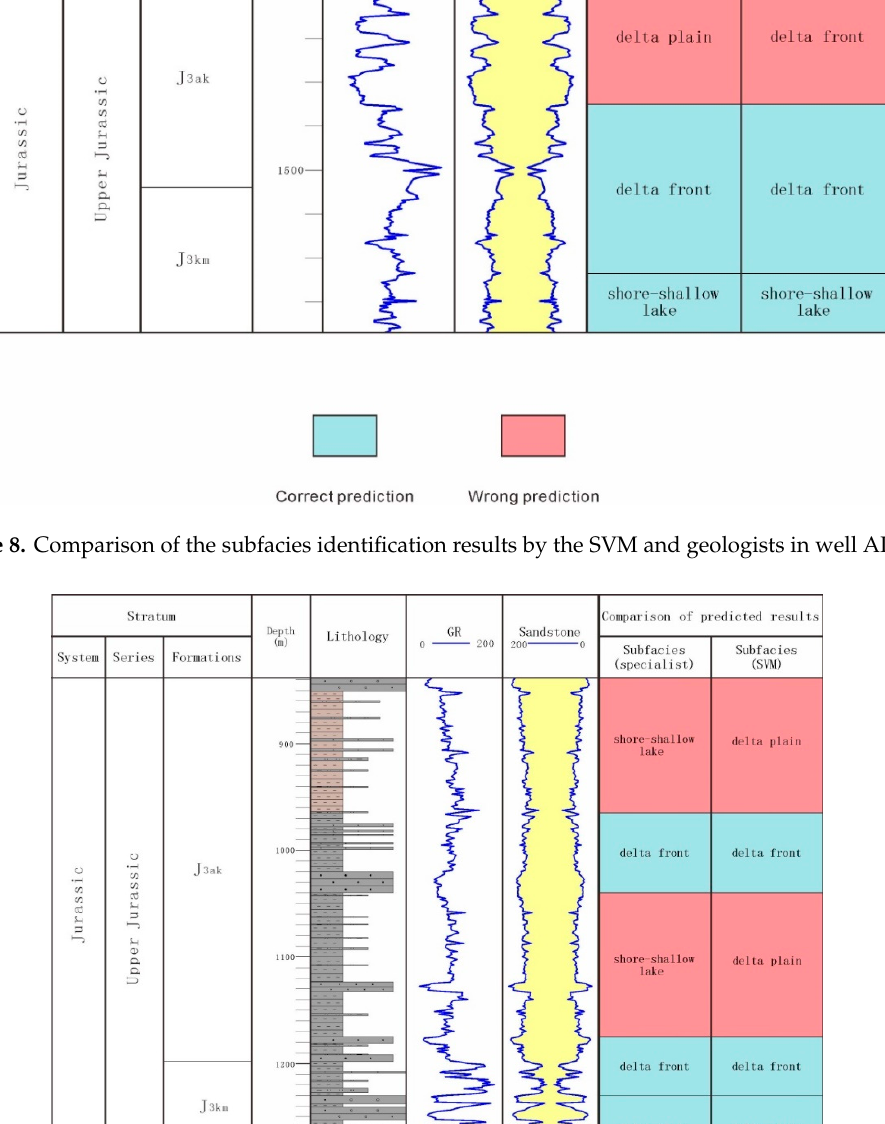
Figure 9. Comparison of the subfacies identification results by the SVM and geologists in well ARY16.